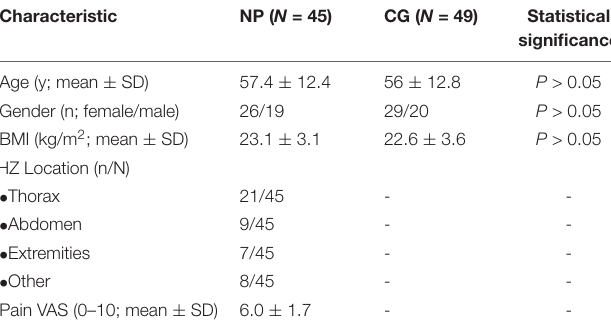
TABLE 3 | Characteristics of patients with NP and the healthy control group (CG). Characteristic